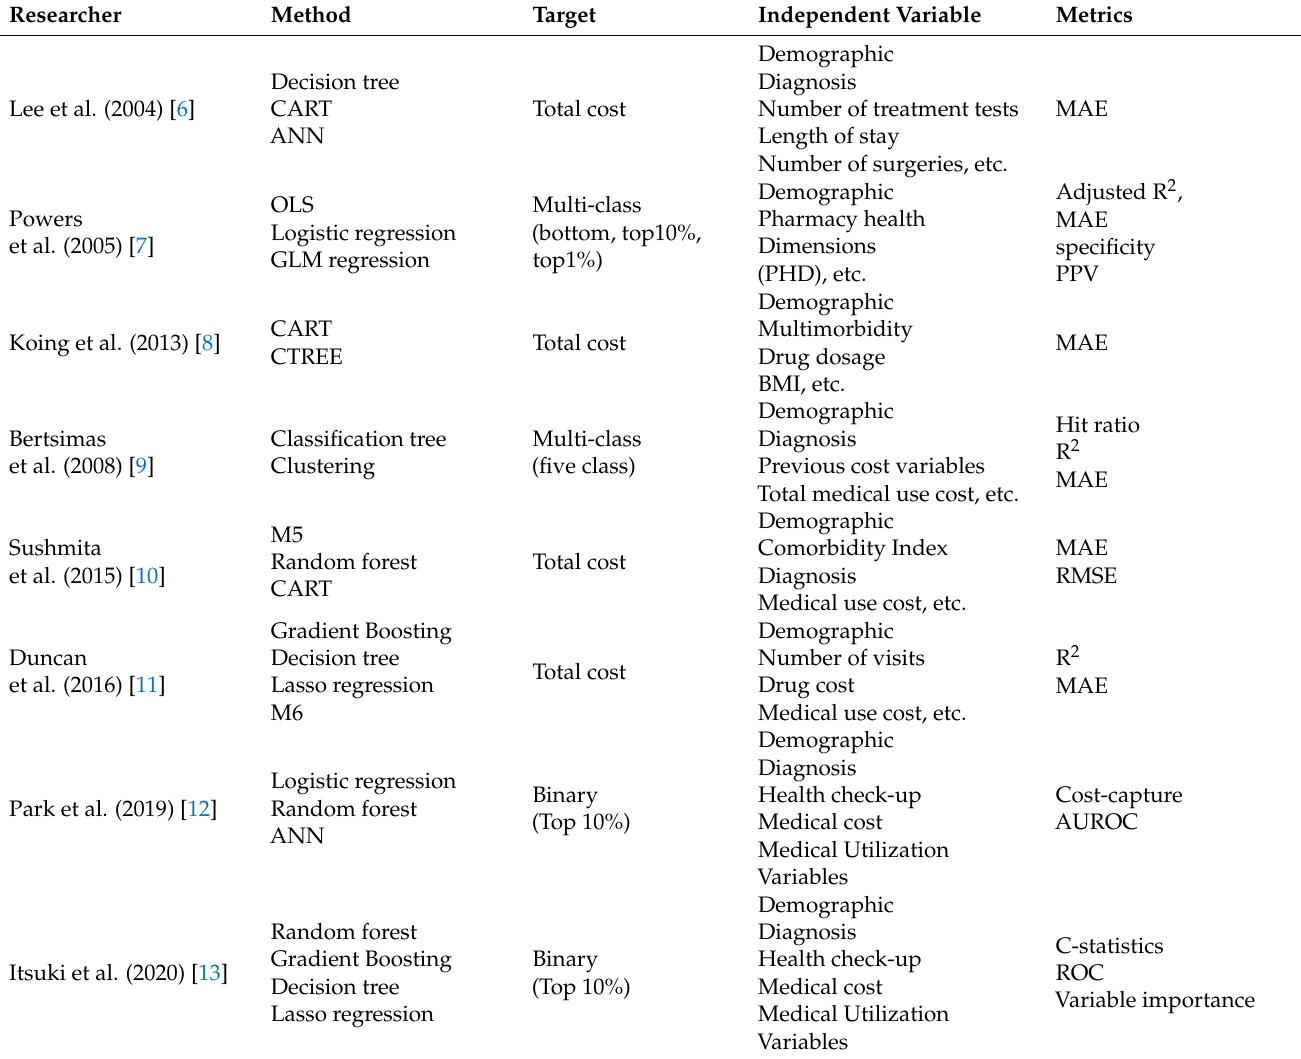
Table 1. Prediction of medical expenses performed prior